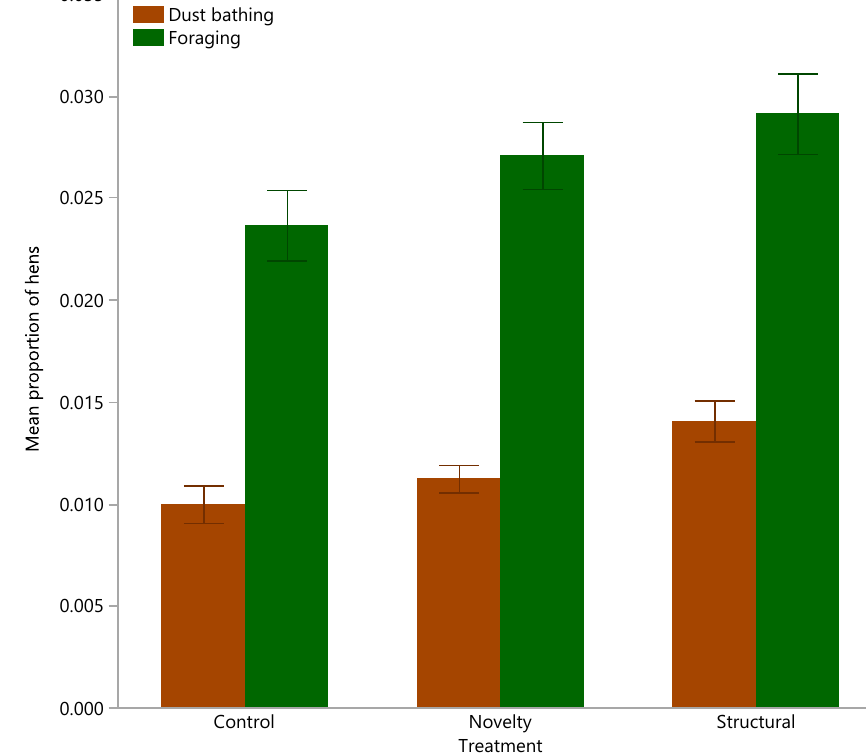
Figure 4. The mean ( ± SEM) proportion of hens summed for both inside the shed and outside on the range exhibiting dust bathing or foraging behavior across the flock cycle from three rearing treatments (control, novelty, structural). Raw data are presented.